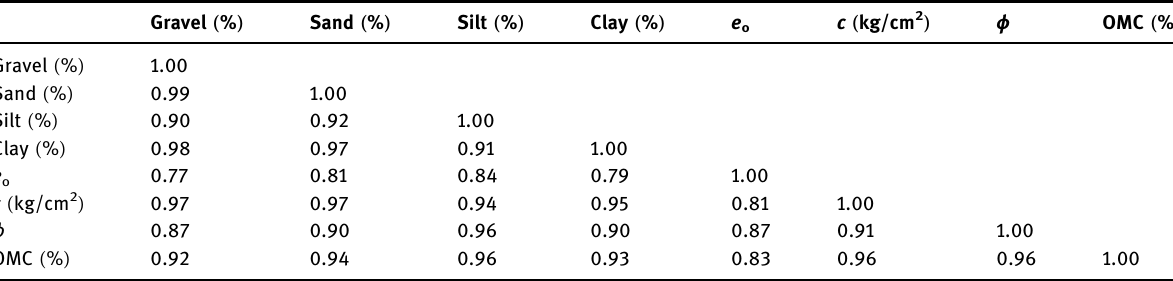
Table 2: Correlation between various geotechnical characteristics for Kirkuk city Gravel ( % ) Sand ( %